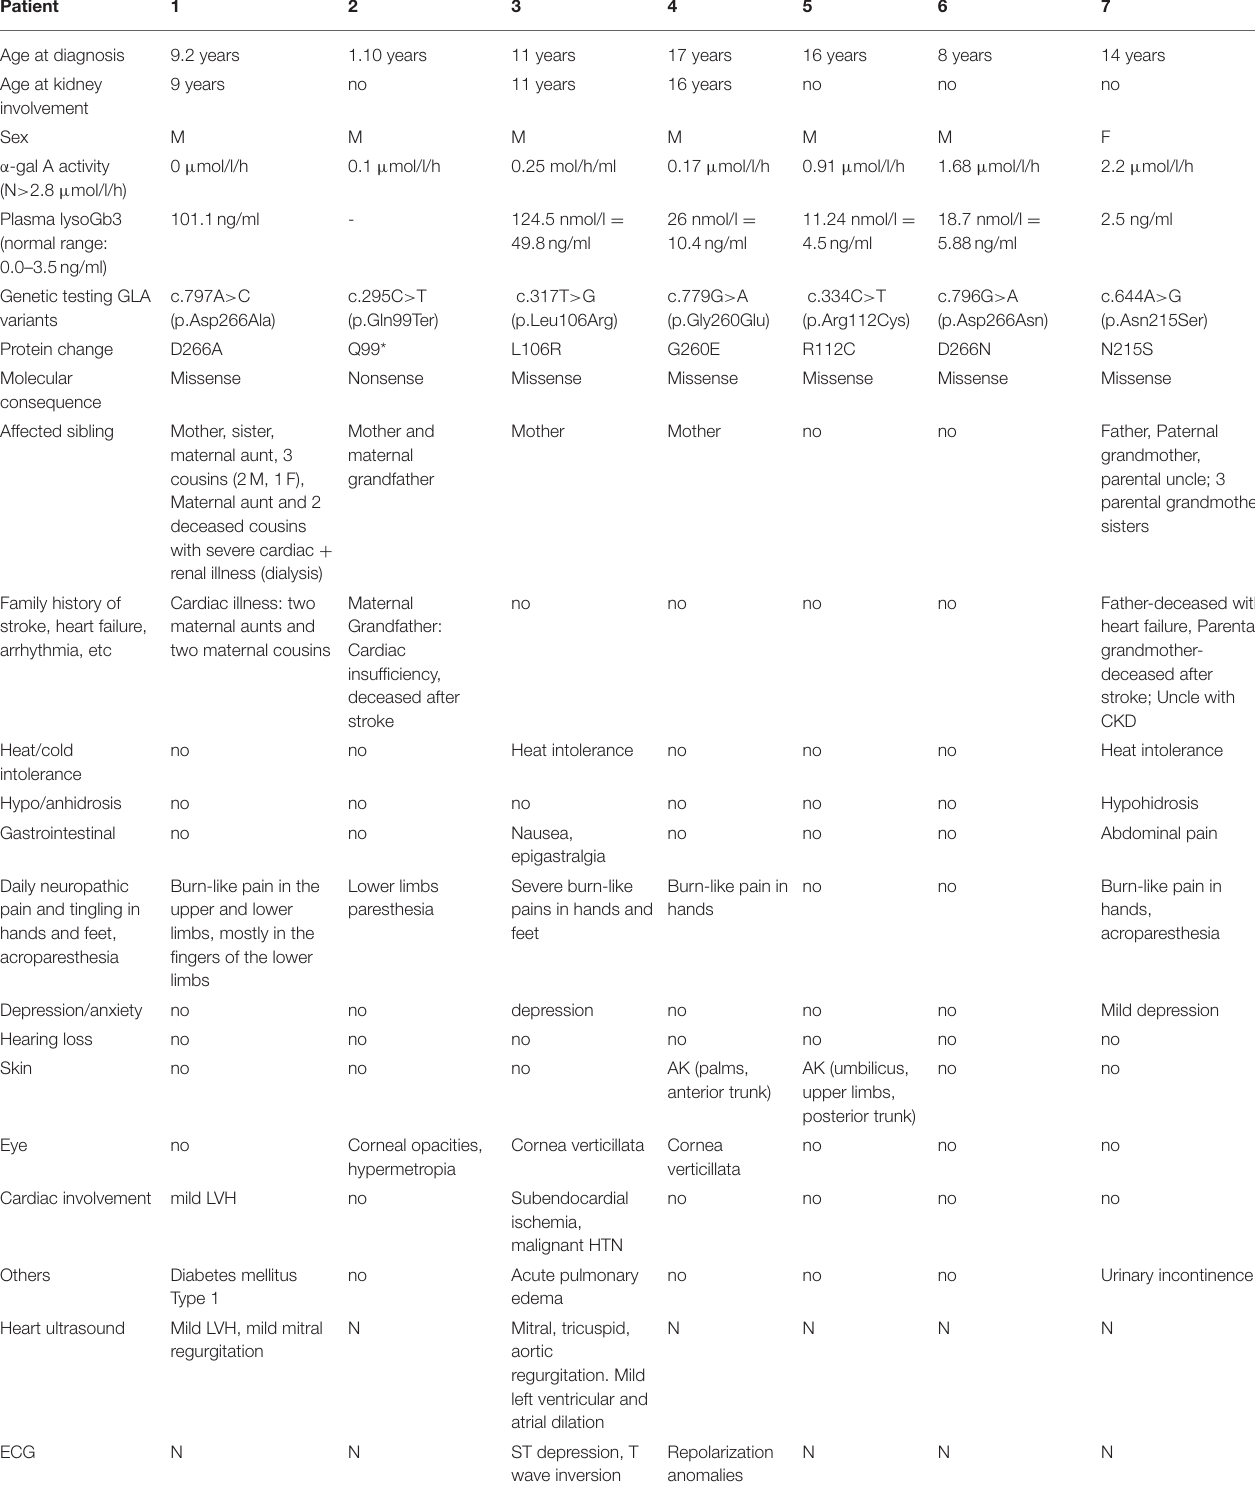
TABLE 3 | Clinical characteristics and laboratory tests of the affected patients/individuals.